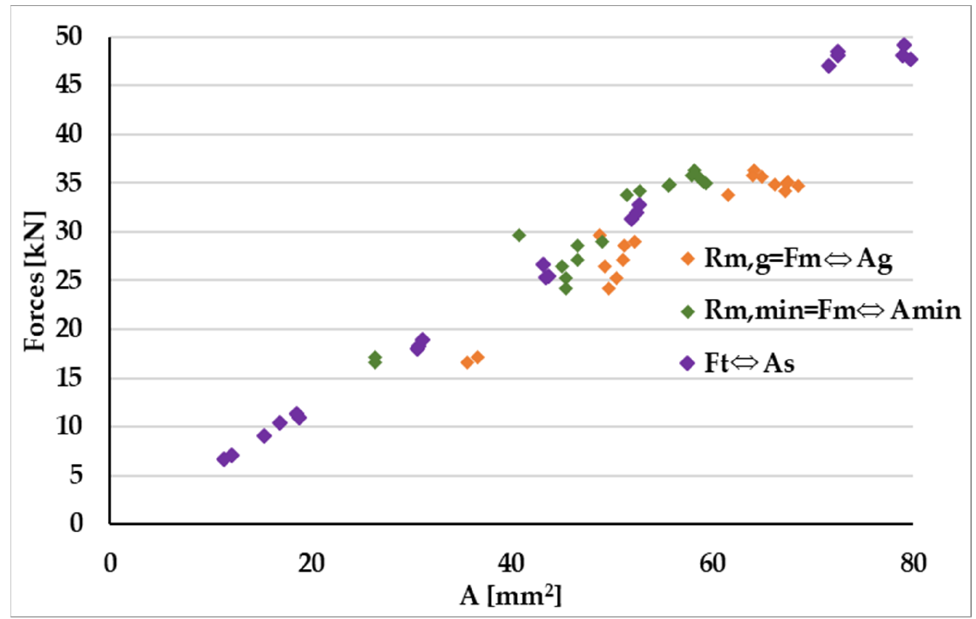
Figure 15. Dependence of the force on the tensile strength F m related to the relevant area of the cross-section ϕ 10 (to minimum area A min and to the area determined from the weight loss A g ).